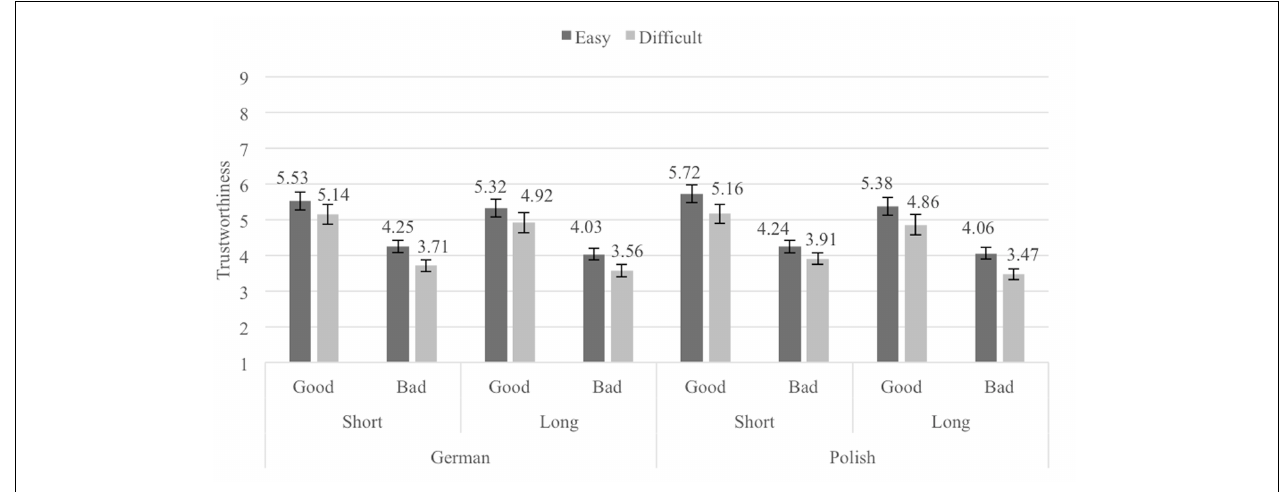
FIGURE 7 | Average trustworthiness ratings in Experiment 5, by Seller Origin, Length, Pronounceability, and Reputation condition; error bars denote standard errors.